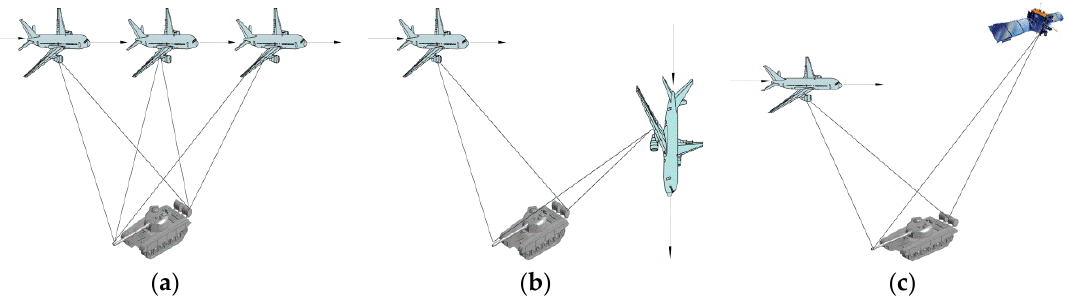
Figure 3 . Illustration of the collection of multi-view synthetic aperture radar (SAR) images: ( a ) Consecutive views by the sensor; ( b ) Views with different azimuths from different sensors; and ( c ) Views from air-borne and satellite-based sensors.